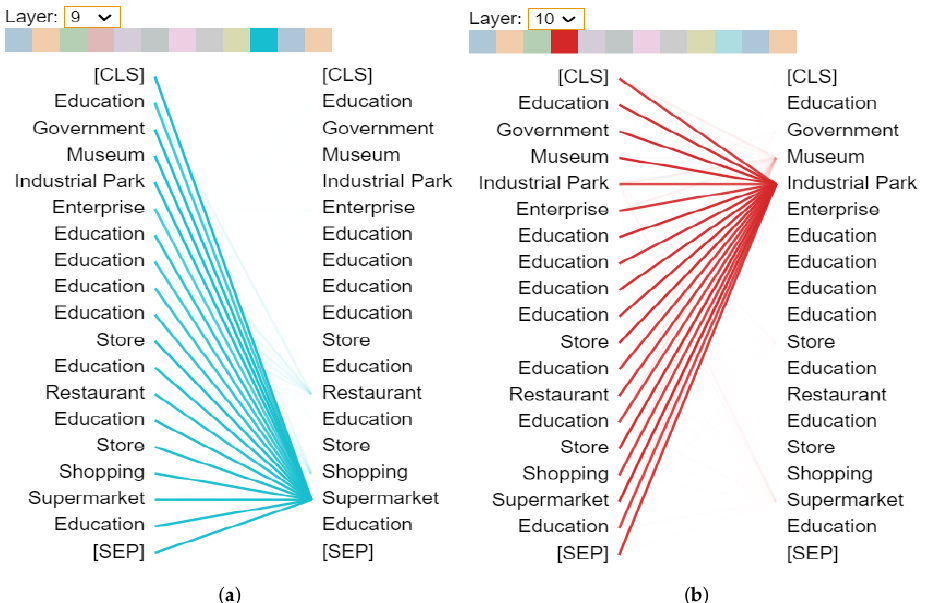
Figure 21. Attention mechanism for addition Case 2 in GeoBERT-ShortestPath. The phenomenon is evident, and the above two heads each identify an anchor POI, namely “Supermarket” and “Industry Park”: ( a ) Layer 9, Head 9; ( b ) Layer 10, Head